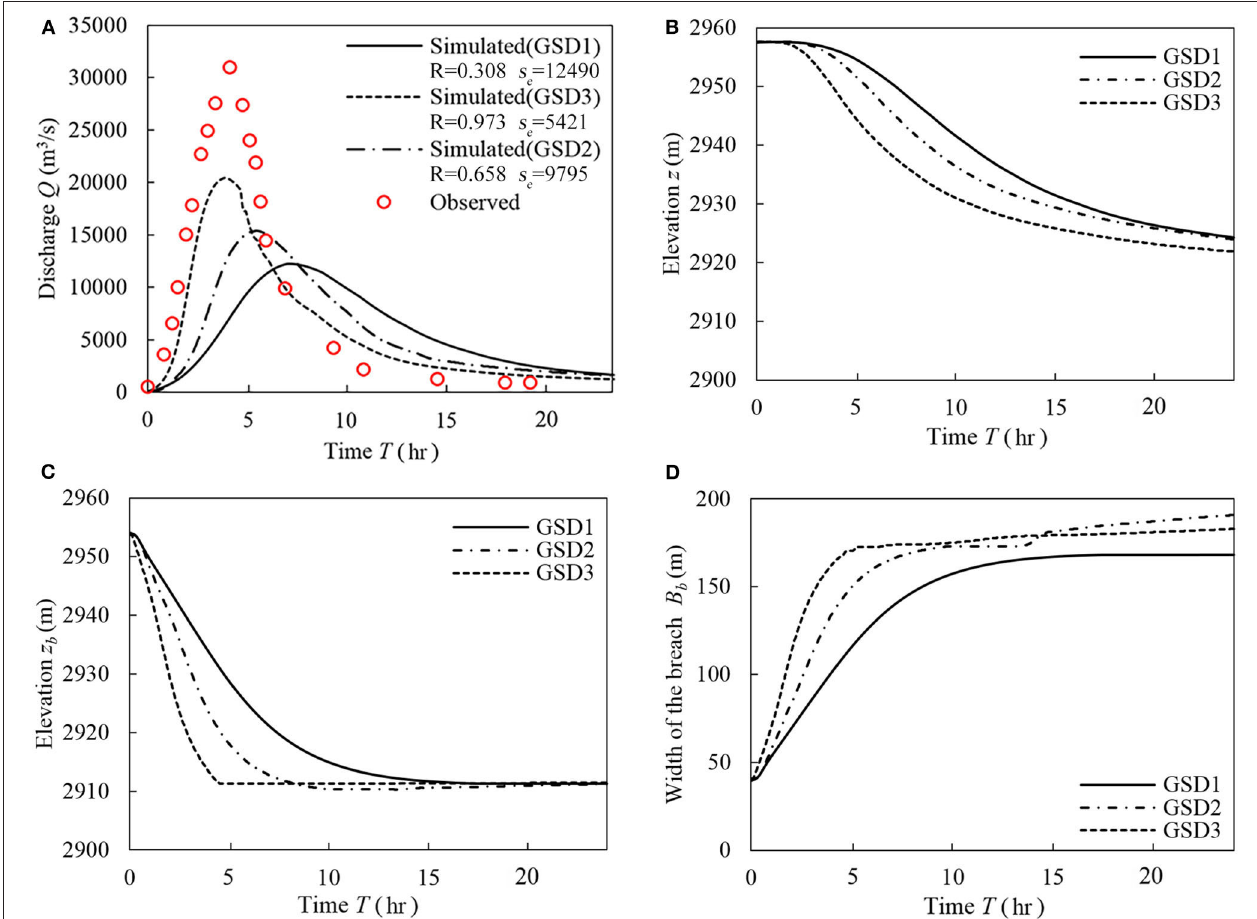
FIGURE 12 | The breach process of the “November 3” Baige barrier dam with different GSDs. (A) the simulated hydrographs and the observed one. The Pearson correlation coefficients R under different GSDs vary in the range of 0.308–0.973, and the values of root mean square error RMSE ( s e ) vary in the range of 5,421–12,490; (B) simulated water level; (C) simulated bed elevation at the inlet; (D) simulated width of the breach channel at the